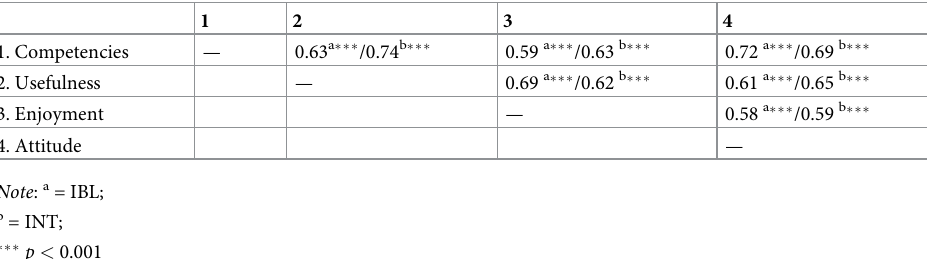
Table 4. Correlations between scores of the individual-level predictors ( competencies , usefulness , and enjoyment ) and effect ( attitude ). Case study: IBL (N 1 = 300)/INT (N 2 = 300).